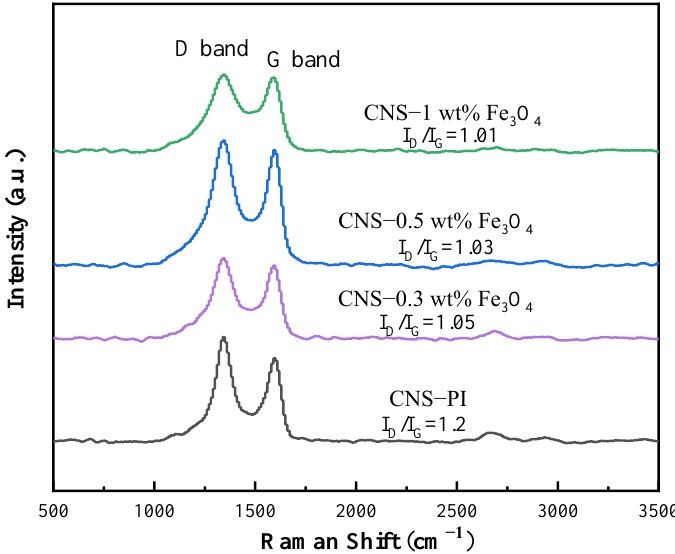
Figure 6. Raman spectra of laser-ablated Fe 3 O 4 /PI composite films with different Fe 3 O 4 content.